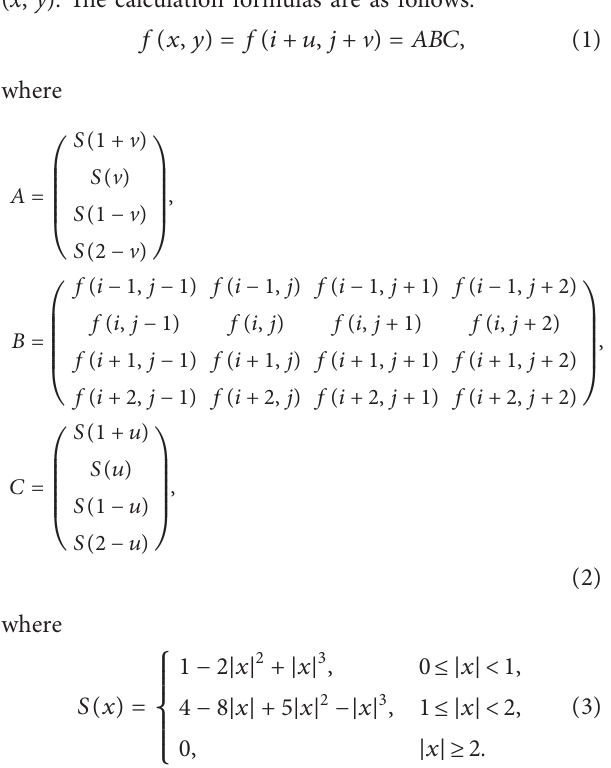
Figure 4: Subimages decomposed by first-level wavelet dbN. (a) Approxiamtion A (d) diagonal detail D 1